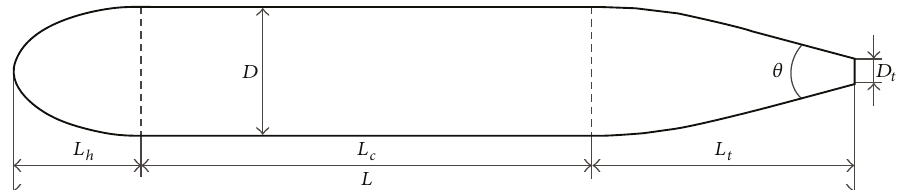
Figure 2: Shape of the AUV.